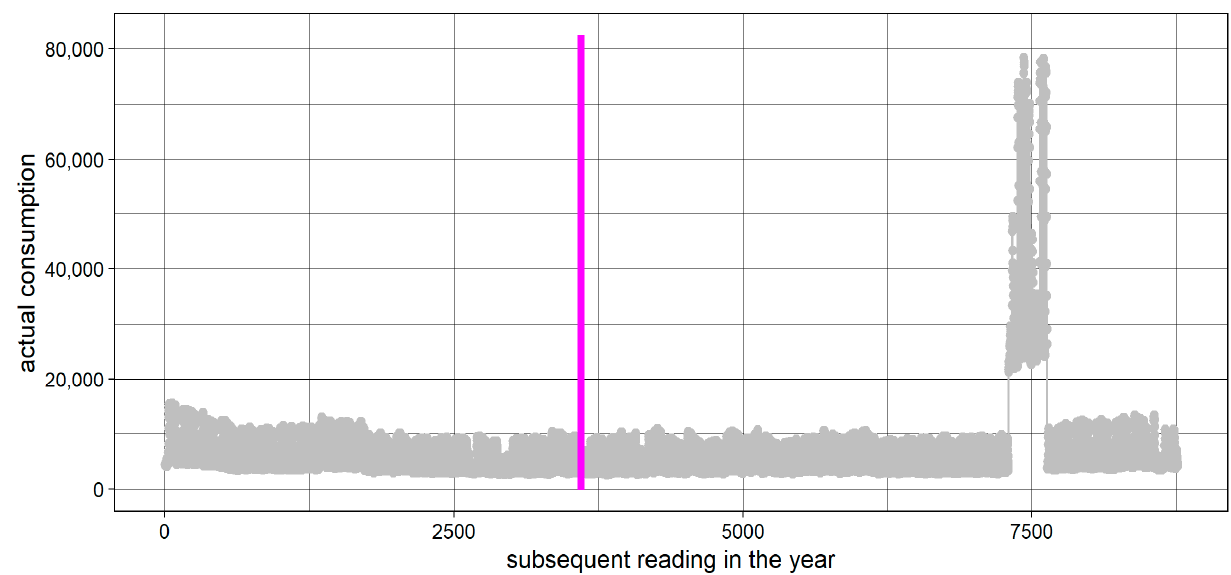
Figure 4. PPE-Example3—course of the series with marked missing data (48 missing values, 1 gap, the longest sequence of missing values: 48). Source: own elaboration.